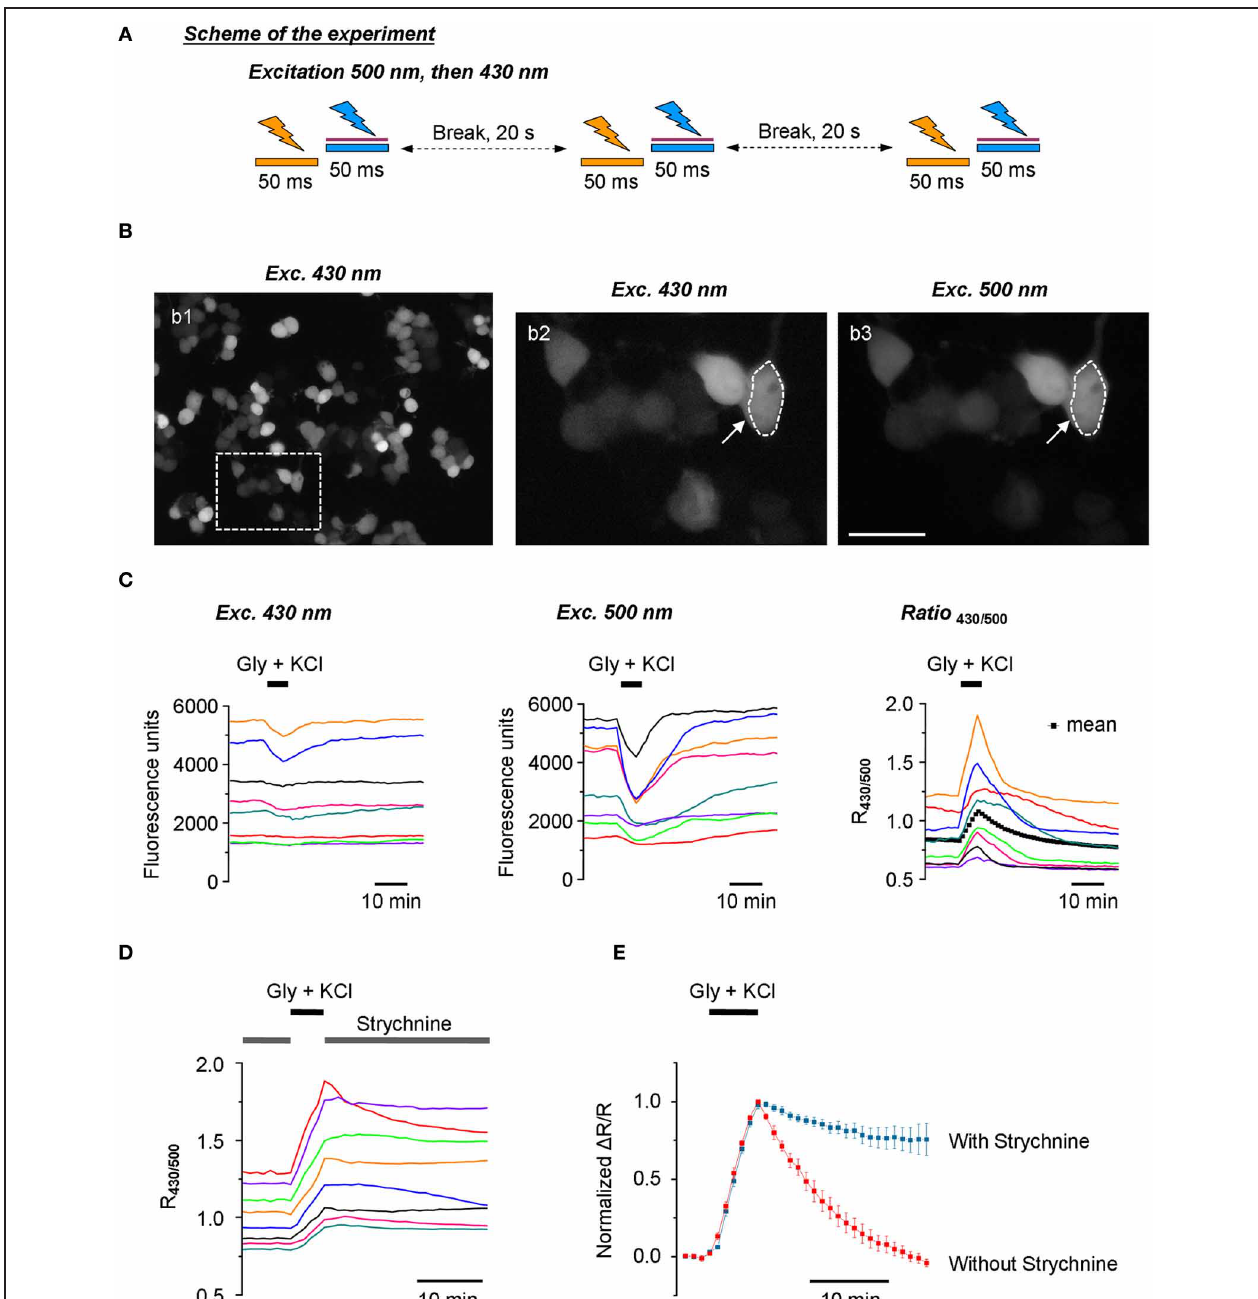
FIGURE 5 | Stable recording of Cl-Sensor fluorescence using the updated setup. (A) Scheme of the experiment: Cl-Sensor was excited every 20s using two consecutive 50ms light pulses through first a 500nm and then a 430nm excitation filter. The sequence of excitation was different as compared to Figure 2A . (B) Example of N2a cells transfected with Cl-Sensor and excited at 430nm (panel b1). CCD camera binning was settled 4 × 4. The image in panel b2 shows a digitally amplified region from b1. Image in b3 shows fluorescence obtained using 500nm excitation (CCD binning 2 × 2). The arrow indicates an example of a region of interest (ROI) drawn around a cell to measure fluorescence intensity. Scale 20 μ m. (C) Left and middle plots illustrate recordings of fluorescence induced using 430nm and 500nm excitation pulses. The